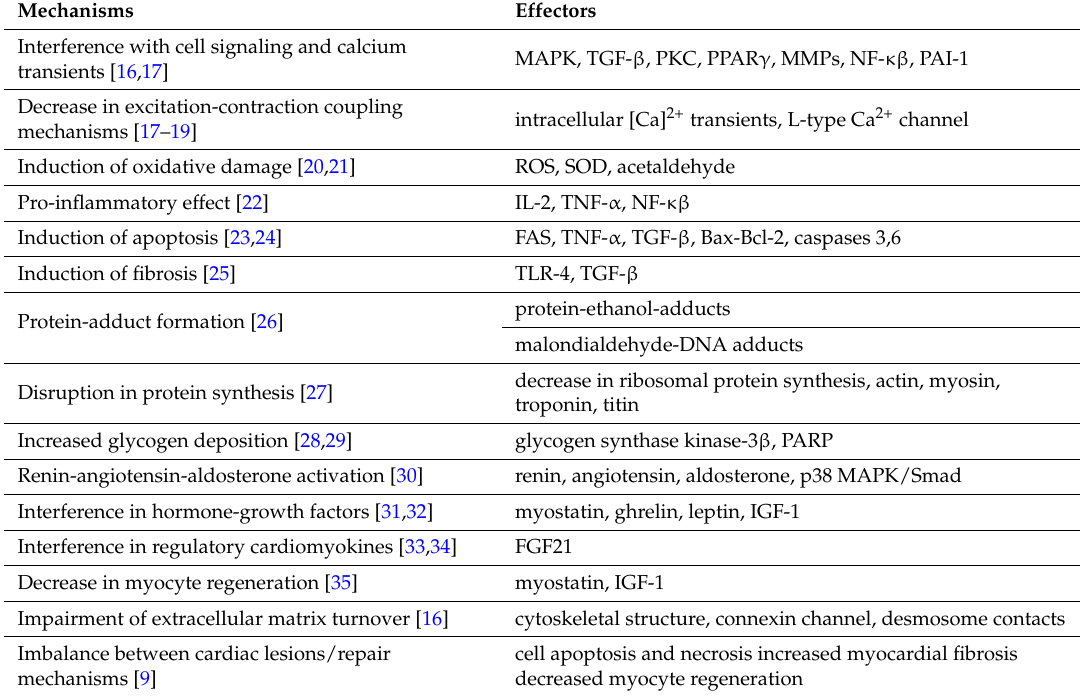
Table 1. Mechanisms of alcohol-induced heart